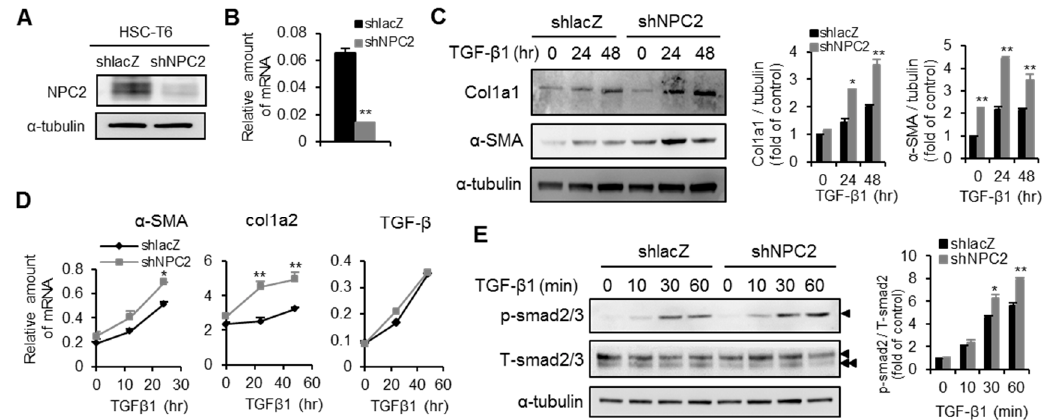
Figure 4. Knockdown of NPC2 increases TGF- β 1induced fibrogenesis in HSC-T6 cells. HSC-T6 cells were infected by lentiviruses carrying the shlacZ control and shNPC2 gene. After puromycin-based selection for 1 week, the cells were harvested and confirmed by ( A ) Western blotting and ( B )